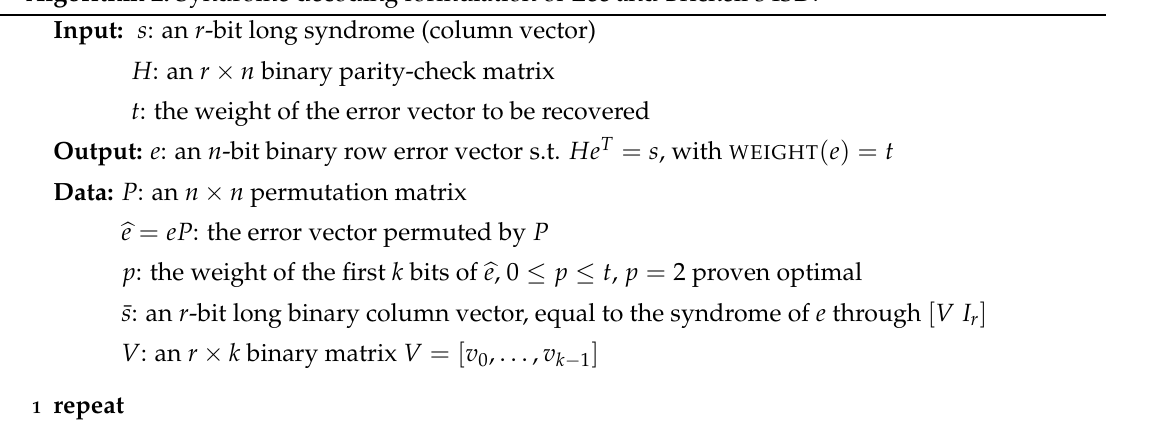
Algorithm 2: Syndrome decoding formulation of Lee and Brickell’s